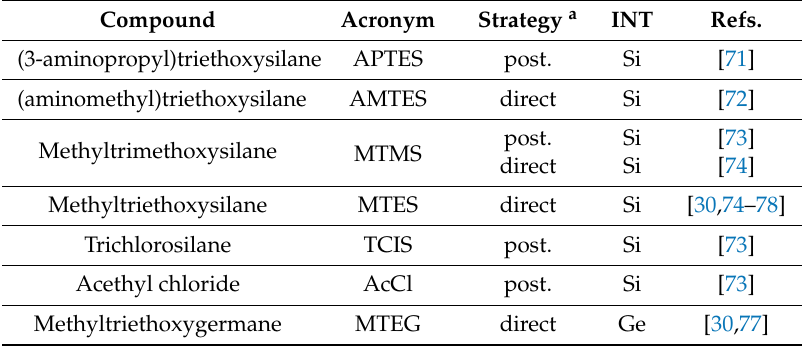
Table 1. Coupling agents used for inner modification (tetrahedral sites) of imogolite nanotubes (INT). Compound Acronym Strategy a INT Refs. (3-aminopropyl)triethoxysilane APTES post. Si [71] (aminomethyl)triethoxysilane AMTES direct Si [72] post. Si [73] Methyltrimethoxysilane MTMS direct Si [74] Methyltriethoxysilane MTES direct Si [30,74–78] Trichlorosilane TCIS post. Si [73] Acethyl chloride AcCl post. Si [73] Methyltriethoxygermane MTEG direct Ge